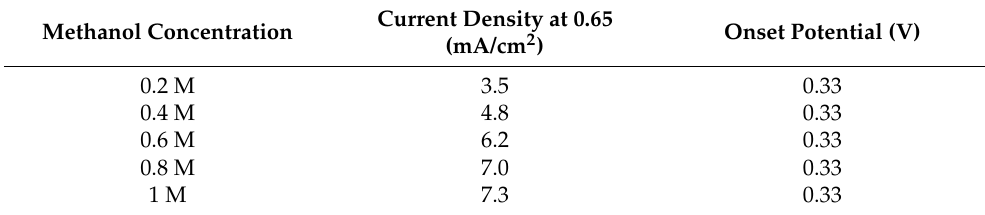
Table 3. Current densities of NiO-ZrO 2 /FTO for different concentrations of methanol at specified onset potentials. Methanol